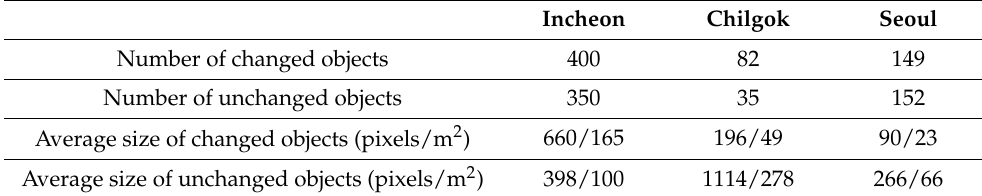
Figure 6. Examples of changed reference objects (marked in orange) and unchanged objects (marked in green) from ( a ) Incheon, ( b ) Chilgok, and ( c ) Seoul. Table 2. The quantity and sizes of reference objects.